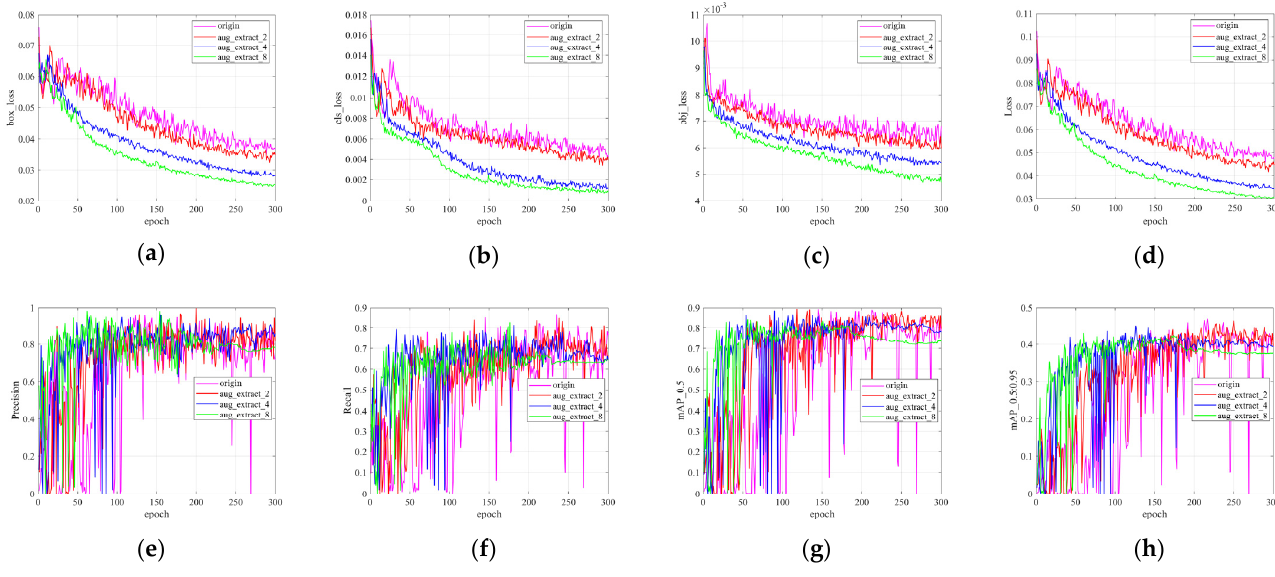
Figure 9. The training details of station spacing augmentation strategy: ( a ) box_loss ; ( b ) cls_loss ; ( c ) obj_loss ; ( d ) total of three loss; ( e ) precision; ( f ) recall; ( g ) mAP_0.5; ( h ) mAP_0.5:0.95.